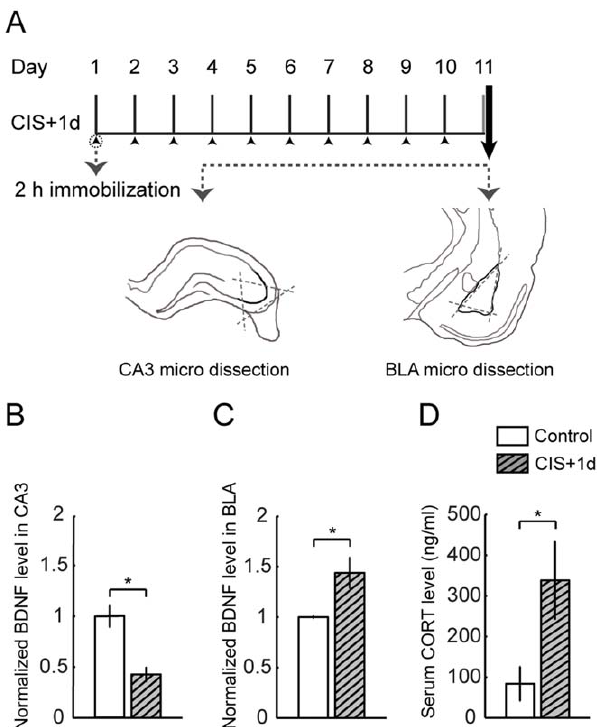
Figure 1. Chronic stress regulates BDNF expression in CA3 and BLA in contrasting manner. Data are presented as mean 6 SEM. A Experimental design of chronic stress (CIS + 1d) followed by micro dissection of area CA3 from transverse hippocampal sections or BLA from coronal sections. B BDNF expression in area CA3 is decreased after chronic stress (Control, n=5; CIS + 1d, n=5), C Chronic stress up regulates BDNF expression in BLA (Control, n=6; CIS + 1d, n=8). Chronic stress induced changes in BDNF expression profile is normalized to respective control level. D Serum corticosterone levels are up regulated after chronic stress in comparison to controls (Control, n=5; CIS + 1d, n=6). Significant differences *, p , 0.05; Unpaired, two-tailed, Student’s t-test was used to compare stress and control